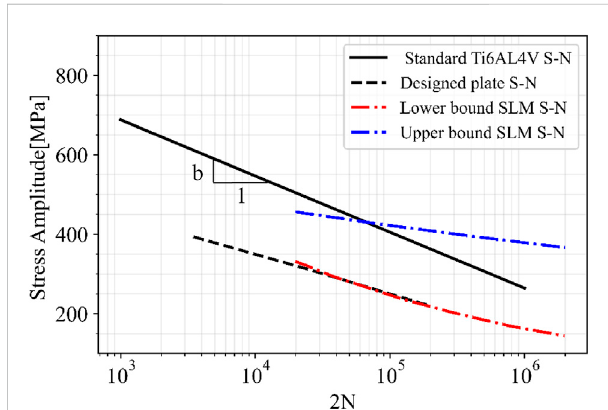
FIGURE 11 Stress versus number of cycles to failure for standard Ti6AL4V (when, σ m (cid:1) 0 ), and designed plate compare to that of SLM Ti6AL4V specimens obtained by (Bezuidenhout et al., 2020), as-built (lower bound) and chemically polished surfaces (upper